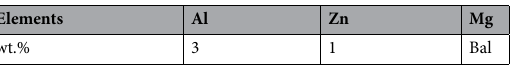
Table 1. The chemical composition of the AZ31